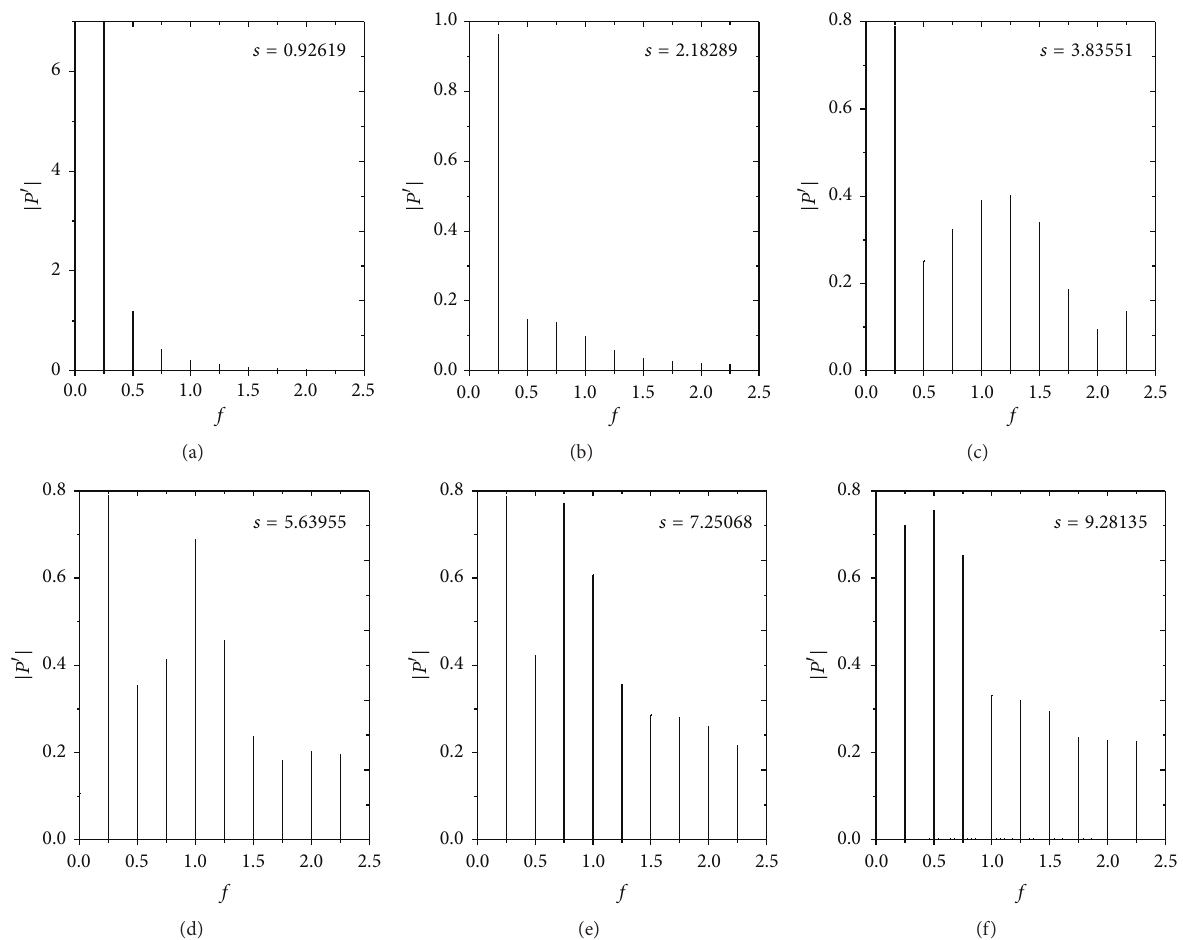
Figure 9: Fourier frequency analysis of pressure disturbance at different surface locations under freestream continuous fast acoustic